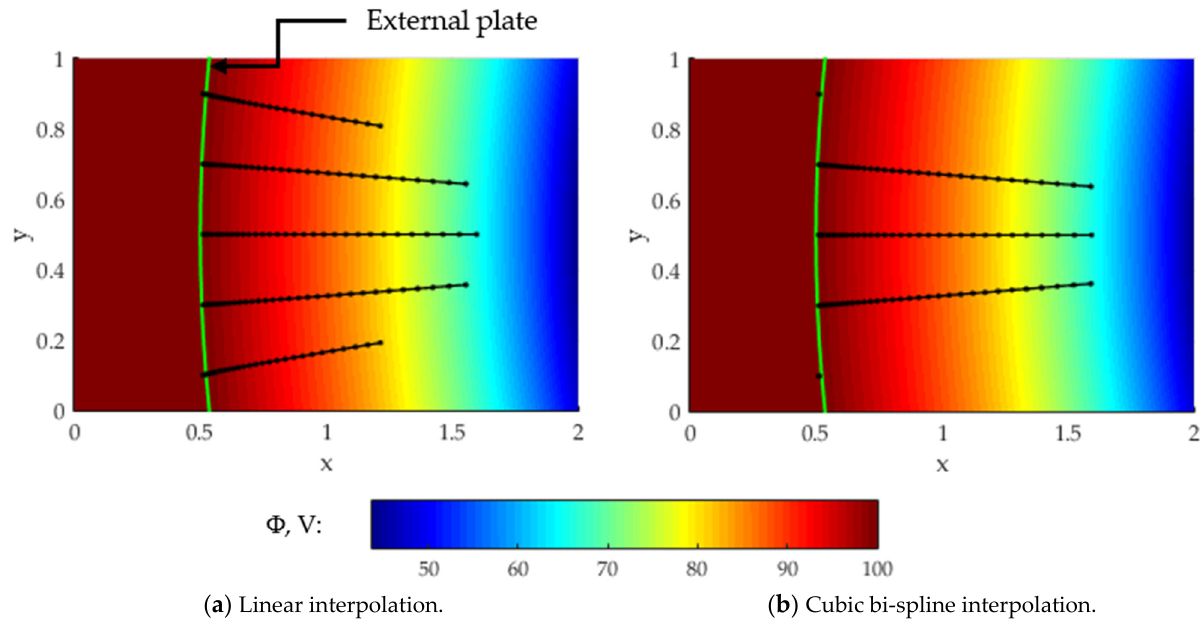
Figure 9. A representation of the motion of 5 ion macro-particles in an electric field generated by 2 thin concentric plates by employing the cubic bi-spline and the linear interpolation.